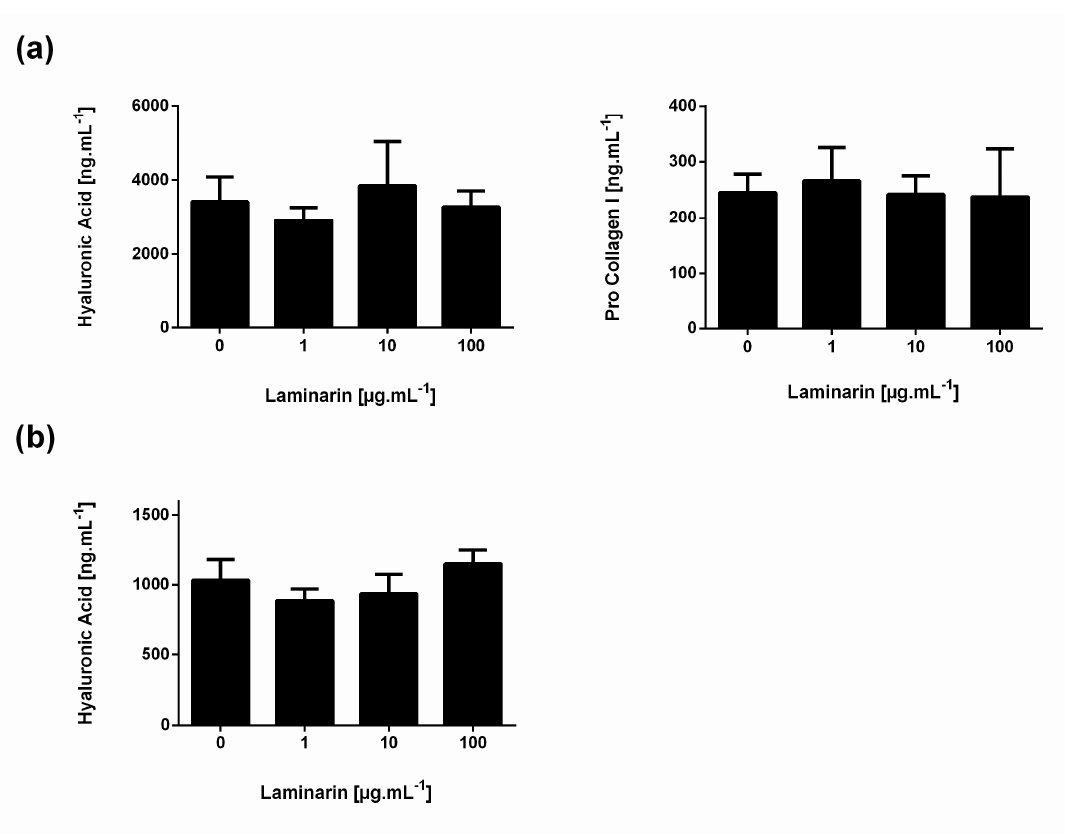
Figure 4. Quantitative analysis of hyaluronic acid (HA) and procollagen I by ELISA assay. ( a ) HDFa and ( b ) NHEK cells were treated with 1, 10 and 100 µg.mL − 1 laminarin for 72 h. An ELISA assay was performed to quantified HA (left) and procollagen I (right) on cell culture medium supernatant. Data are expressed as mean ± SD of three independent experiments.